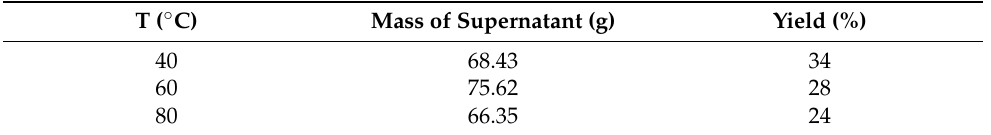
Table 4. Impact of temperature on the conversion yield. Reaction conditions: 10 g of rapeseed cake; 100 mL of formic acid with 4–5 drops of H 2 SO 4 ; stirred at a defined temperature for 15 min. T ( ◦ C) Mass of Supernatant (g) Yield (%) 40 68.43 34 60 75.62 28 80 66.35